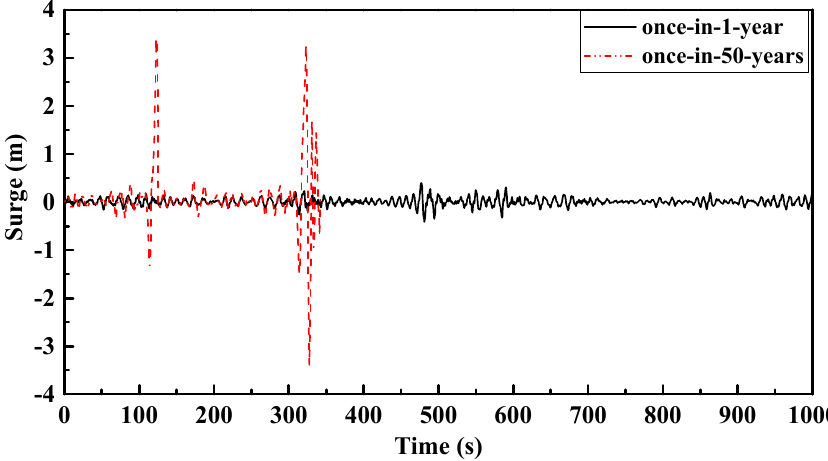
Figure 15. Time series of platform surge motion under extreme sea-states.